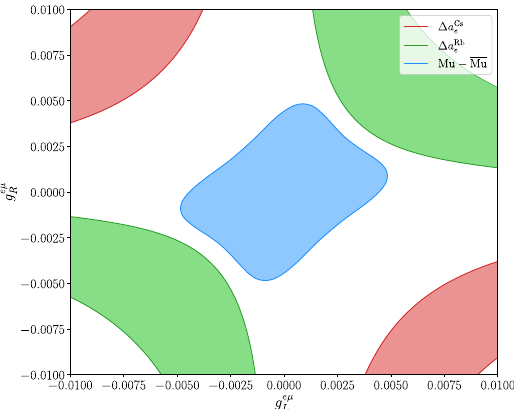
μ couplings and prospects for ( g − 2 ) e . On L , R μ μ - g e ) parameter space, in L R